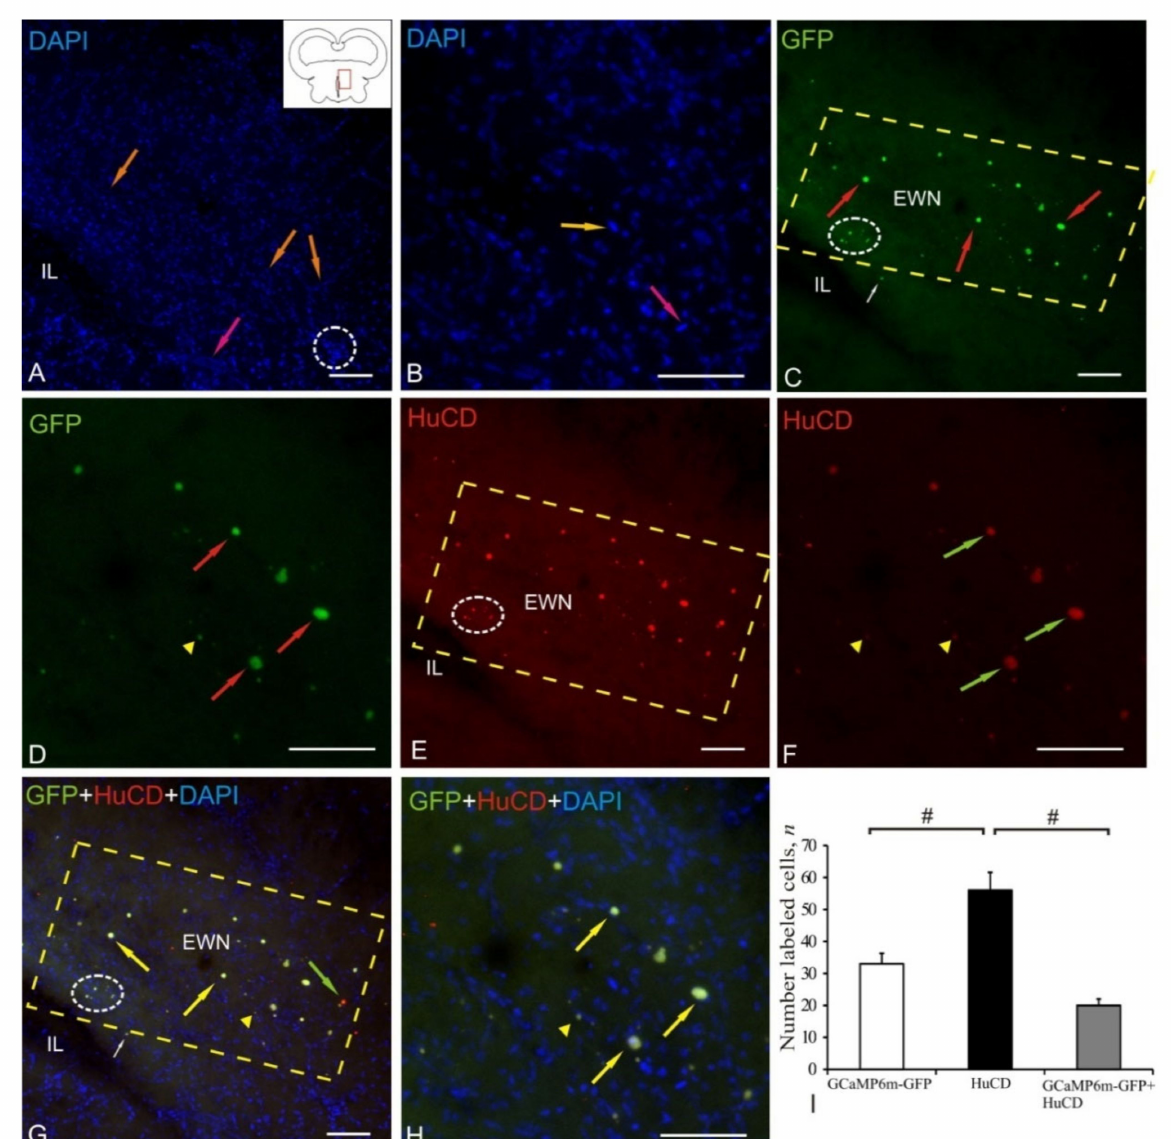
Figure 7. Z-stacks representing HuCD immunolabeling in the Edinger–Westphal nucleus of juvenile chum salmon, O. keta , at 1 week after a single injection of recombinant AAV into the mesencephalic tegmentum area. ( A ) DAPI staining, the pictogram shows the area of the Edinger–Westphal nucleus (outlined by red rectangle) adjacent to the post-injection cavity (IL), single aggregations of nuclei/cells forming neurogenic niches (outlined by white oval) and numerous oval nuclei (orange arrows), or elongated shape (pink arrows). ( B ) At higher magnification, ( C ) GFP expression in cells (red arrows), aggregation of GFP+ granules (in the white oval), single GFP+ nuclei (white arrow). ( D ) At higher magnification, GFP+ granules (yellow arrowhead). ( E ) Immunofluorescence of the HuCD protein in EWN neurons, designations as in B. ( F ) EWN at higher magnification, HuCD+ neuron (red arrows). ( G ) Superposition of three DAPI/GFP/HuCD staining channels showing the areas of GFP/HuCD colocalization in neurons (yellow arrows), nucleus (white arrow), and GFP– /HuCD+ neurons (green arrow). ( H ) Colocalization in EWN at higher magnification. ( I ) Results of ANOVA analysis showing the comparative distribution of labeled cells and nuclei (M ± SD, where M is the mean and SD is the standard deviation) in the Edinger–Westphal nucleus of juvenile chum salmon. Significant intergroup differences (# < 0.05) were found between the groups of GCaMP6m-GFP+ and GCaMP6m-GFP+/HuCD+ cells and between groups of the HuCD+ and GCaMP6m-GFP+/HuCD+ cells ( n = 5 in each